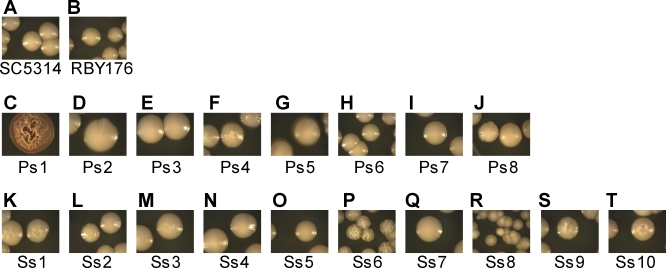
Morphology of Diploid Progeny Strains Derived from the Δspo11 Tetraploid StrainProgeny strains were grown on YPD medium at 30 °C for 7 d and colonies photographed. Progeny strains Ps1 to Ps8 were derived from growth of the Δspo11 tetraploid strain on pre-spo medium, while strains Ss1 to Ss10 were derived from growth on sorbose medium. A control diploid strain (SC5314) and tetraploid strain (RBY176) are shown for comparison.